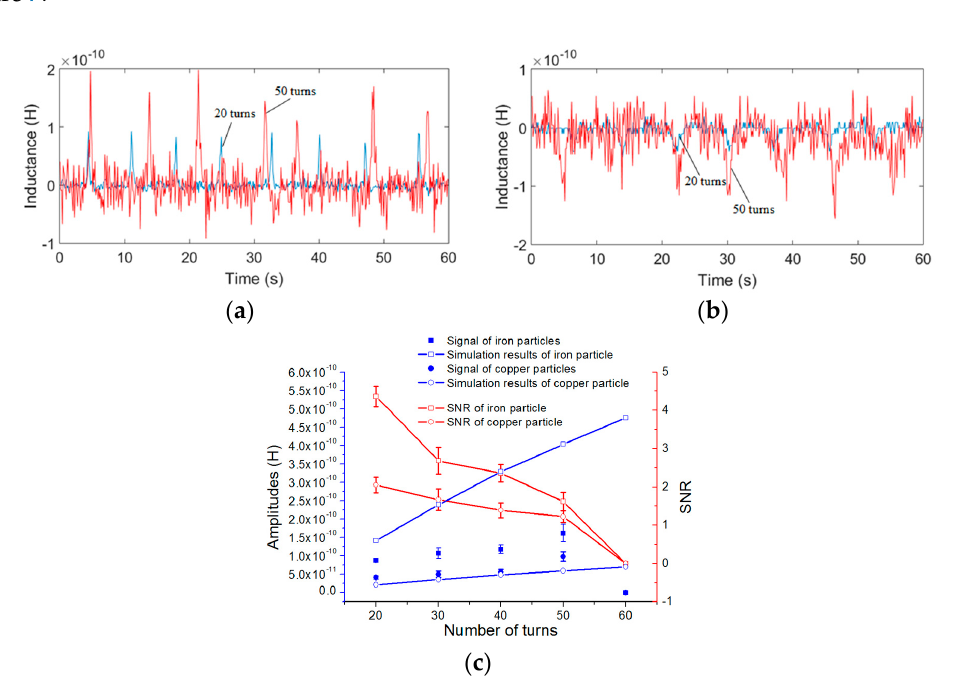
Figure 7. Inductance detection results and theoretical inductance changes for different numbers of turns (excitation frequency was 2 MHz): ( a ) detection results of iron particles with sizes ranging from 70 to 80 μ m, red line was 50 turns and blue line was 20 turns; ( b ) detection results of copper particles with sizes ranging from 120 to 130 μ m, red line was 50 turns and blue line was 20 turns; ( c ) comparison between the experimental results and the analytical predictions for different numbers of turns.